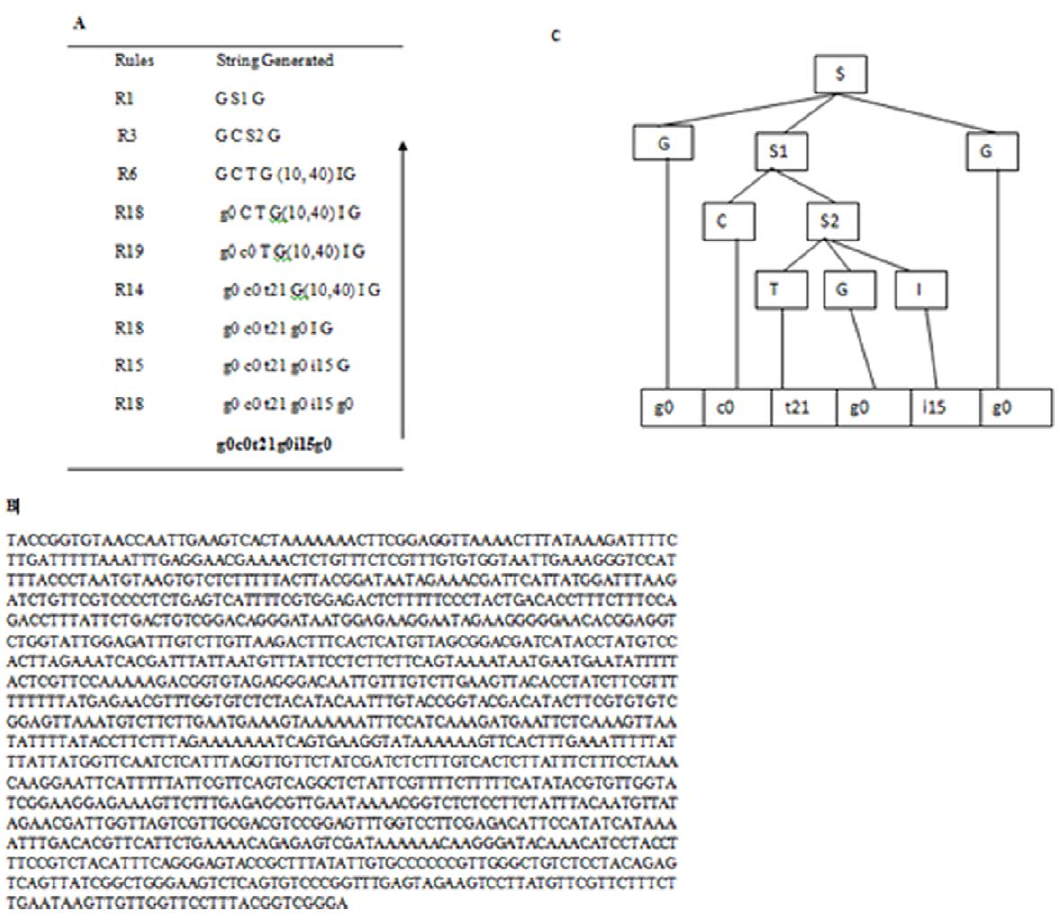
Figure 1. Process of generating the start symbol from input sequence using successive application of the grammar rules. (A) The strings generated by successive application of production rules to guide the design of a promoter region (B) The sequence of a promoter region composing of the parts of the syntactic element for verification (C) the LR parse tree for generating the symbolic description of the sequence using grammar rules.